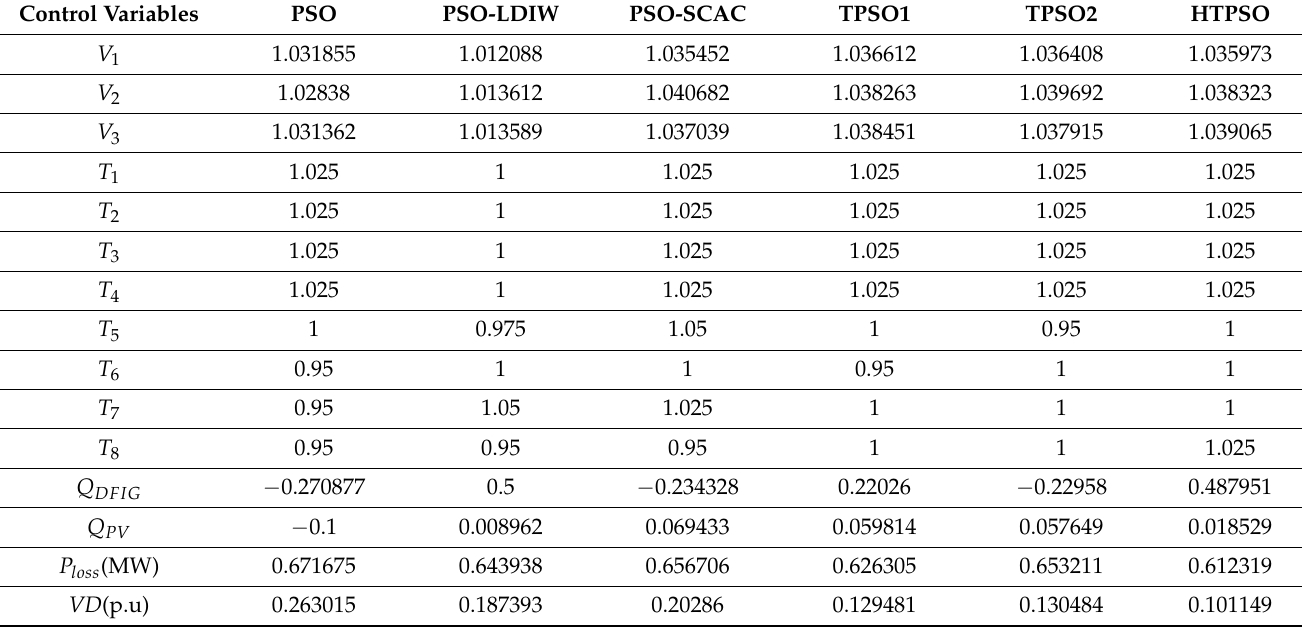
Table 7. Control variable results after optimization of different algorithms.